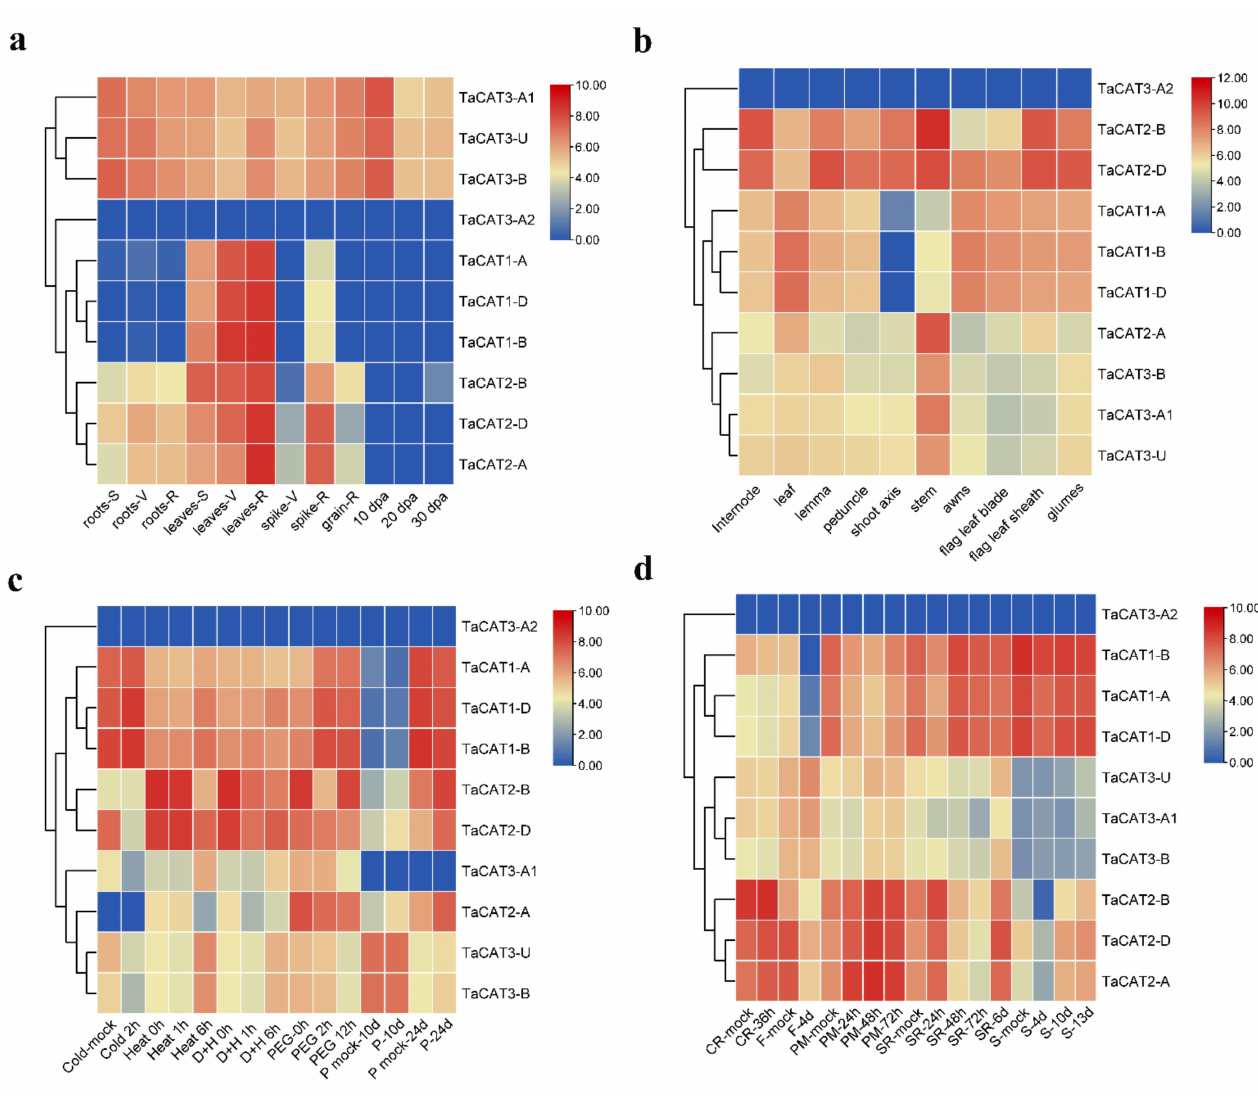
Figure 6. Expression analysis of TaCAT genes in different tissues of different developmental stages and stress treatments. ( a ) hierarchical clustering of expression profiles of wheat CAT genes in different tissues at seedling, vegetative, reproductive phase, and 10, 20, 30 dpa. S, seedling phase; V, vegetative phase; R, reproductive phase; dpa, day post-anthesis; ( b ) hierarchical clustering of expression profiles of TaCAT genes in different tissues at a milk grain stage; ( c ) hierarchical clustering of expression profiles of TaCAT genes under different abiotic stress treatments. D + H, drought and heat stress; P, phosphorus stress; ( d ) hierarchical clustering of expression profiles of TaCAT genes under different biotic stress treatments. CR, crown rot; F, fusarium hormones; PM, powdery mildew; SR, stripe rust; S,